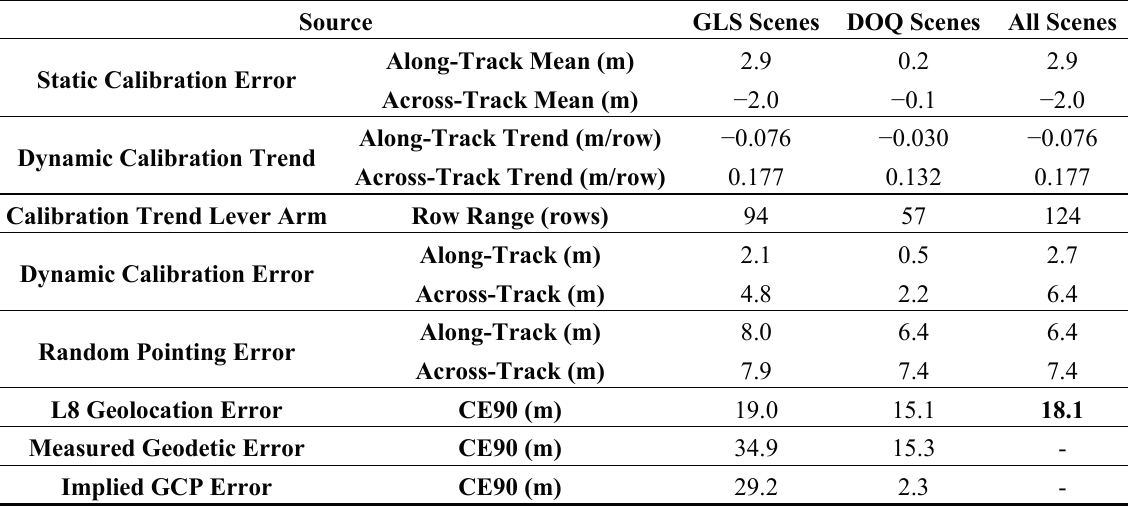
Table 3. Landsat 8 global geolocation accuracy performance estimate. The final estimate is highlighted in bold in the